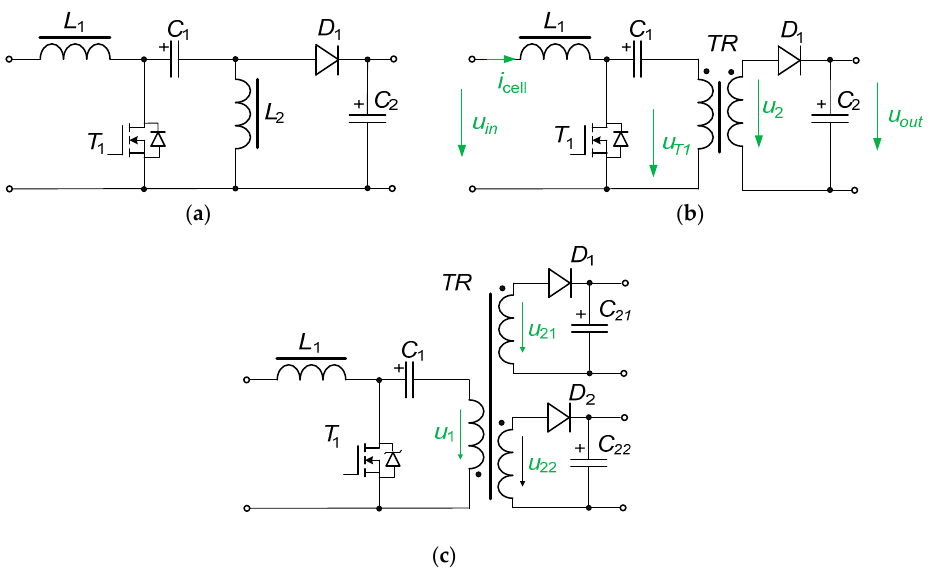
Figure 3. Typical (a) and proposed (b) charging system configurations.